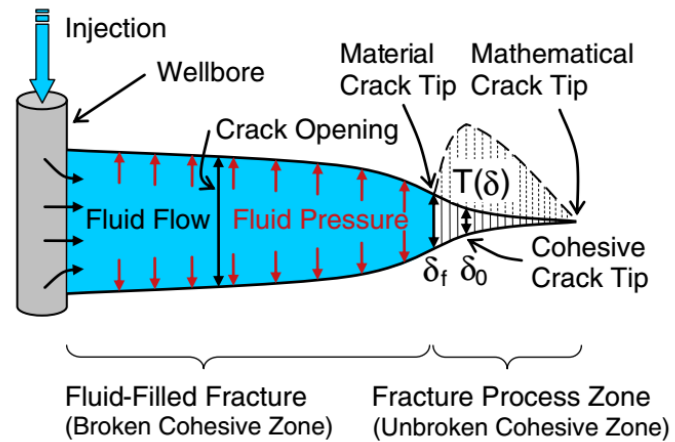
Figure 2. Schematic of hydraulic fracture and fluid flow depicted by cohesive zone model (CZM). Reproduced with permission from [27], Copyright Elsevier, 2020.